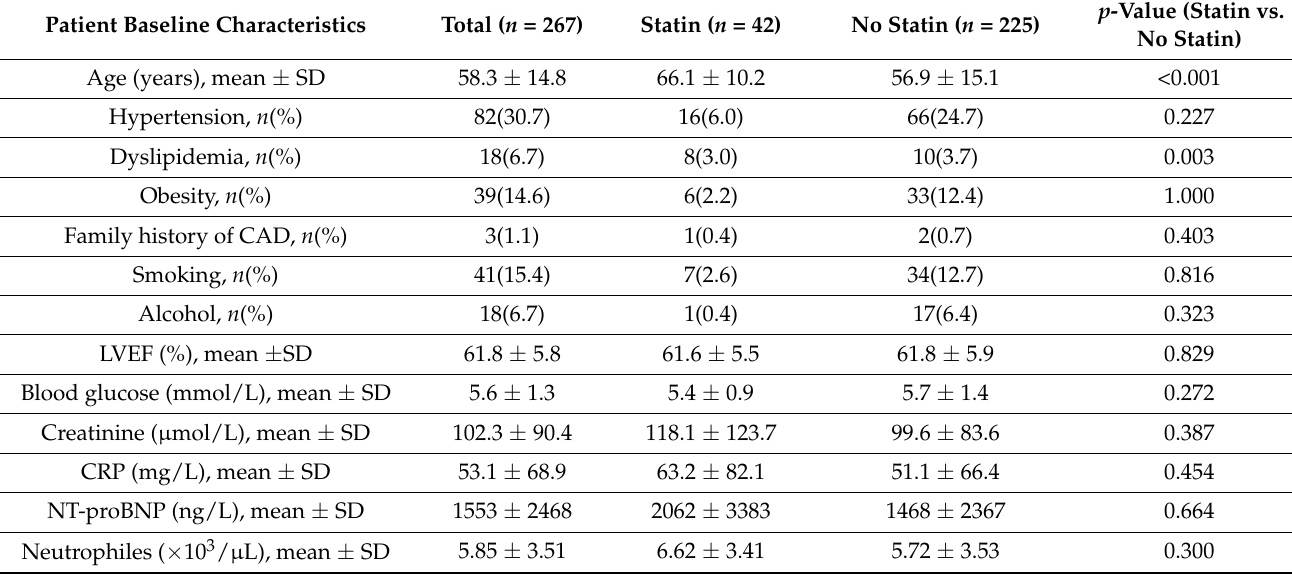
Table 1. Patient baseline